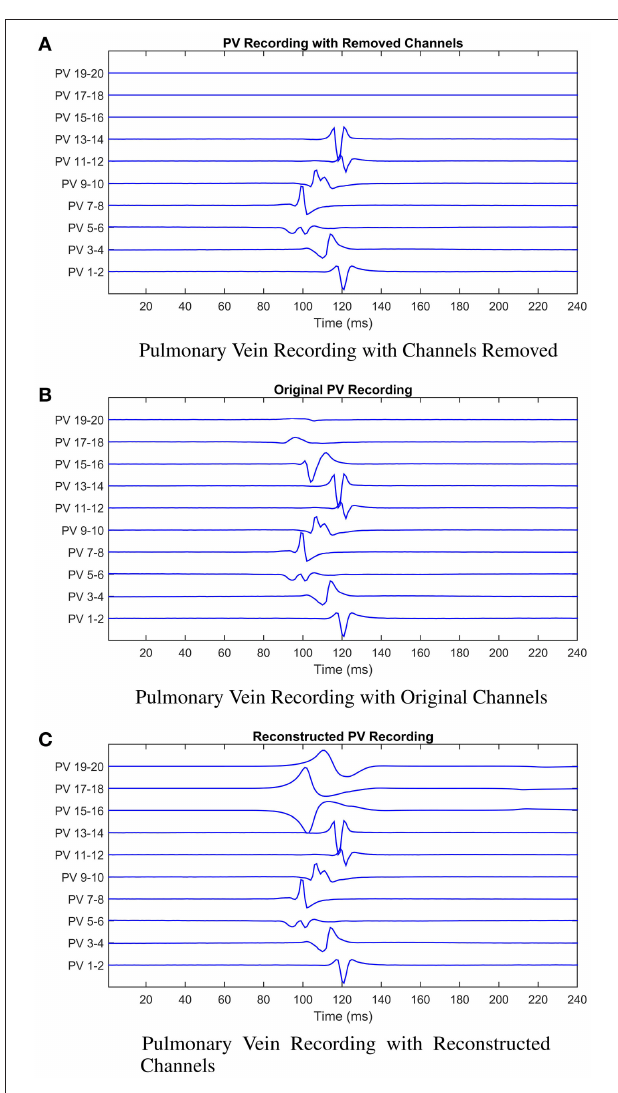
FIGURE 7 | Illustrating the model reconstruction of pulmonary vein recordings. In (A) we present the original recording with three removed channels. In (B) the original recordings, and in (C) the original recordings combined with the reconstructed channels using the mathematical model. We presented these data to the cardiologist who made a decision about the tissue underlying the channels they would ablate in each case. This process was repeated for patients 2 and 3. In all three cases reconstruction of the missing signals resulted in an improved clinical decision in contrast to only using the recordings with missing signals.